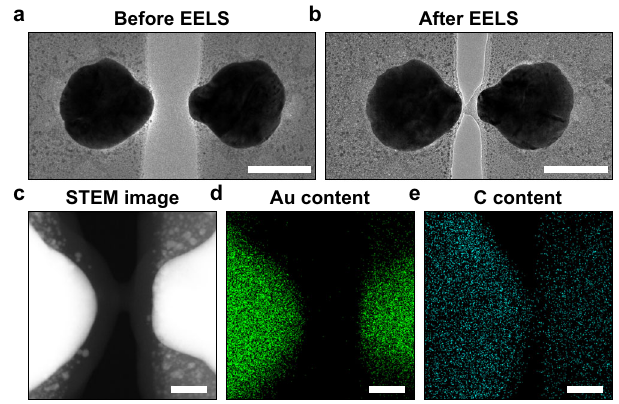
Fig. 3 Formation of a conductive, fl exible gap bridge through EBID. a, b TEM image taken before EELS ( a ), TEM image taken after EELS ( b ). Scale bars: 100 nm. c – e STEM image of EDS inspect region ( c ), EDS map for gold content ( d ), EDS map for carbon content ( e ). Scale bars: 10